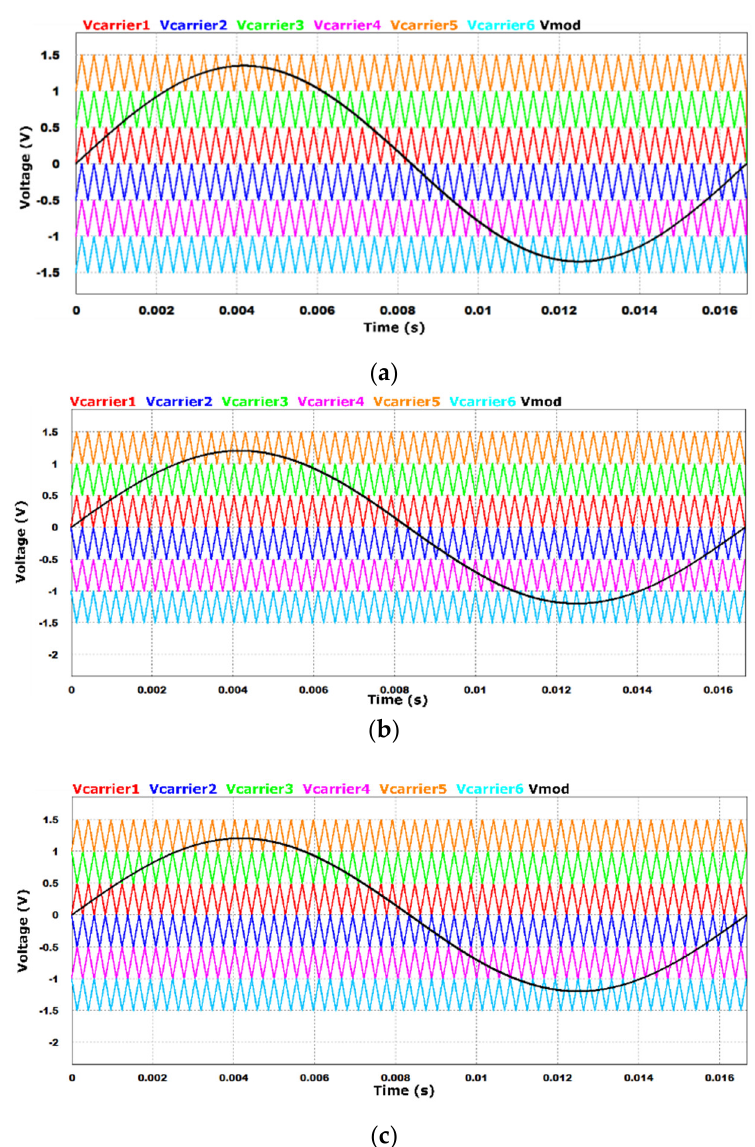
Figure 4. Variants of the PWM modulation strategy of carrier disposition: ( a ) PD, ( b ) POD, and ( c ) APOD.